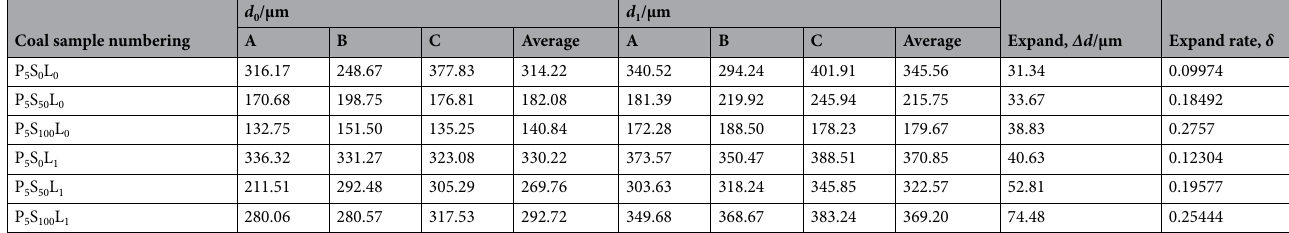
Table 3. Surface joint expansion amount and joint expansion rate of coal samples with different saturation degrees.